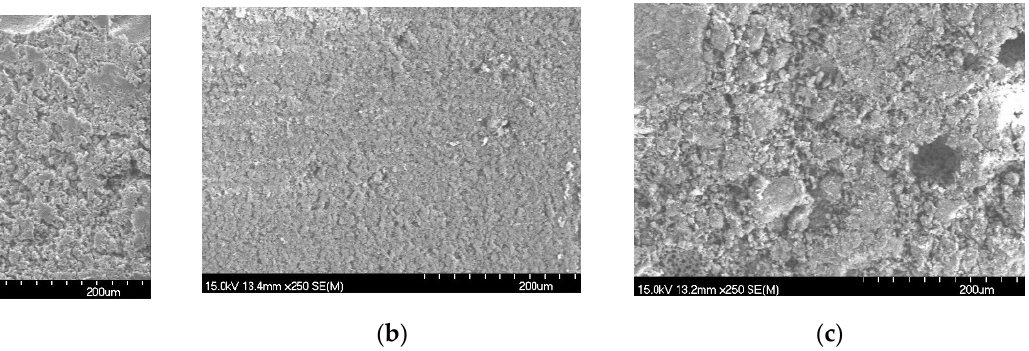
Figure 11. Micro view of polishing tool with different abrasive particle size. ( a ) 200 nm; ( b )1 μ m; ( c ) 5 μ m. Table 5. Compositions of polishing tool with 200 nm abrasive particles.